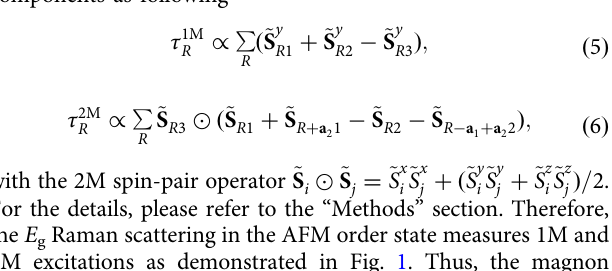
Fig. 4 Power-law behavior for E 2g magnetic Raman continua at low frequency in Cu 3 Zn. a , b are power-law fi tting of χ 00 E temperatures, respectively. c Temperature-dependent exponent α for the power-law